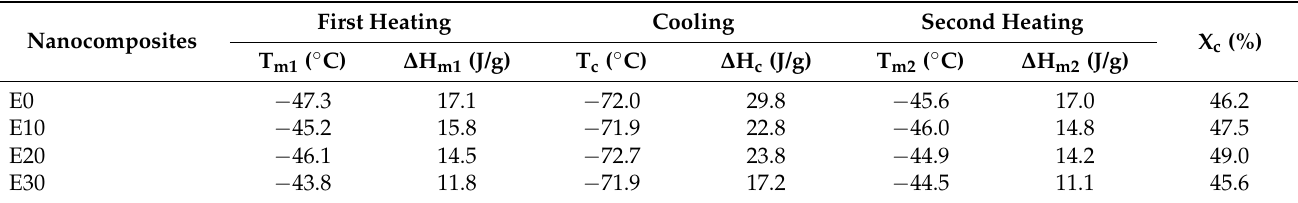
Table 2. DSC data for the nanocomposites.